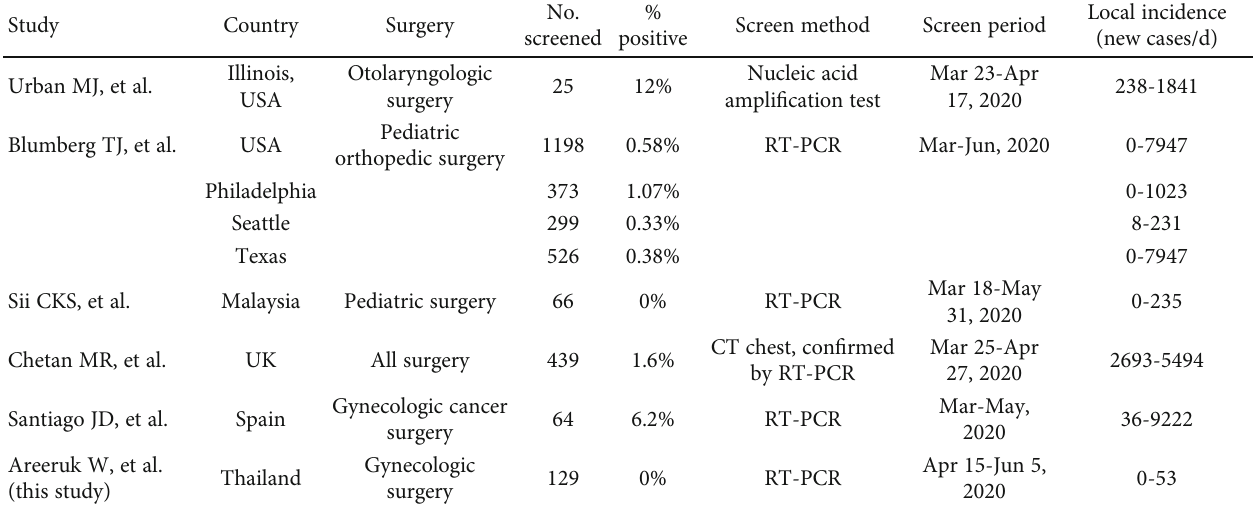
Table 4: Data on preoperative screening for